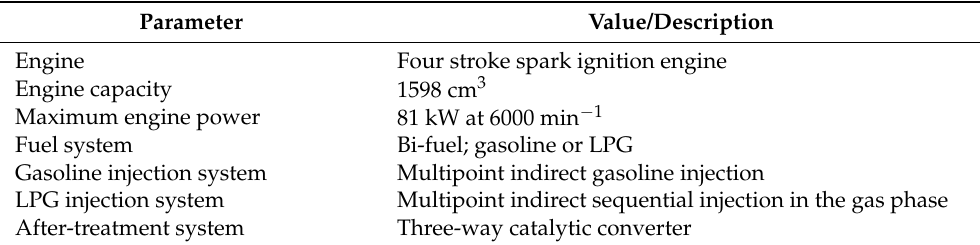
Table 4. Essential data of the tested